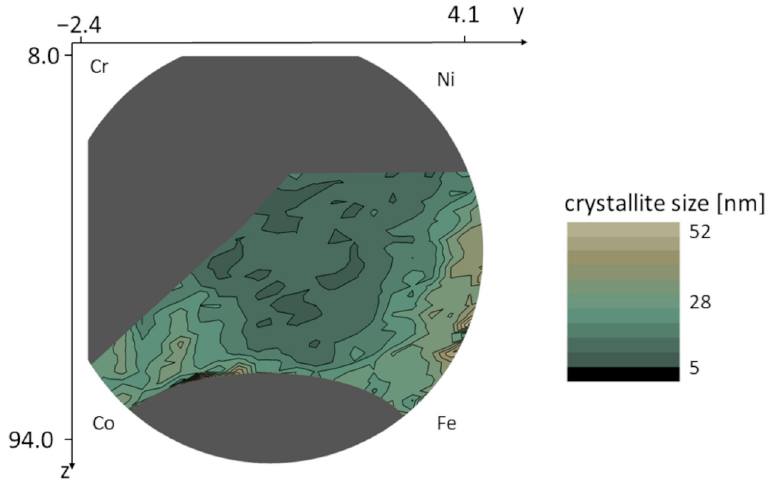
Figure 7. Variation of the crystallite size in the FCC region of the combinatorial Co-Cr-Fe-Ni CCA film.